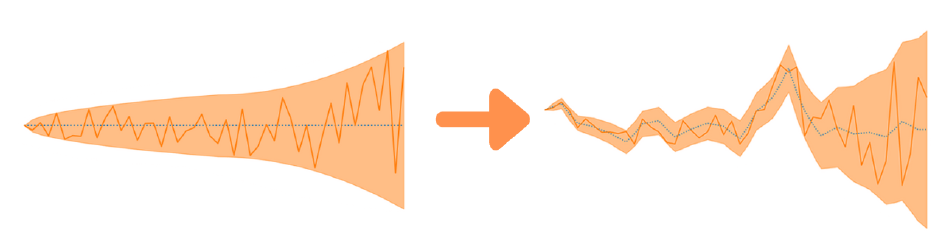
Figure 9. Example of the shape of a converging and diverging margin function on flat original data ( left ) and on actual power data of the London dataset ( right ). The blue line depicts the original power data and the orange line is an example of power forecast data within the orange uncertainty area based on the margin